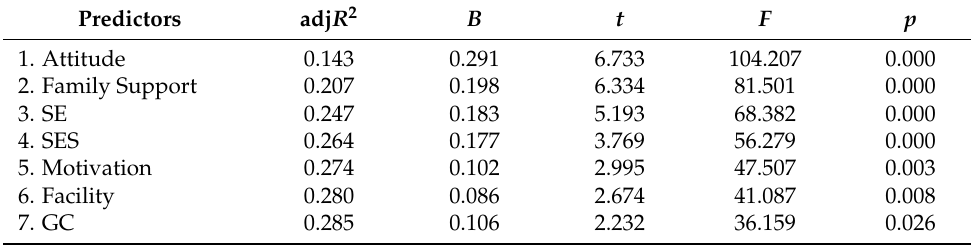
Table 4. Final model of the stepwise regression analysis for predicting